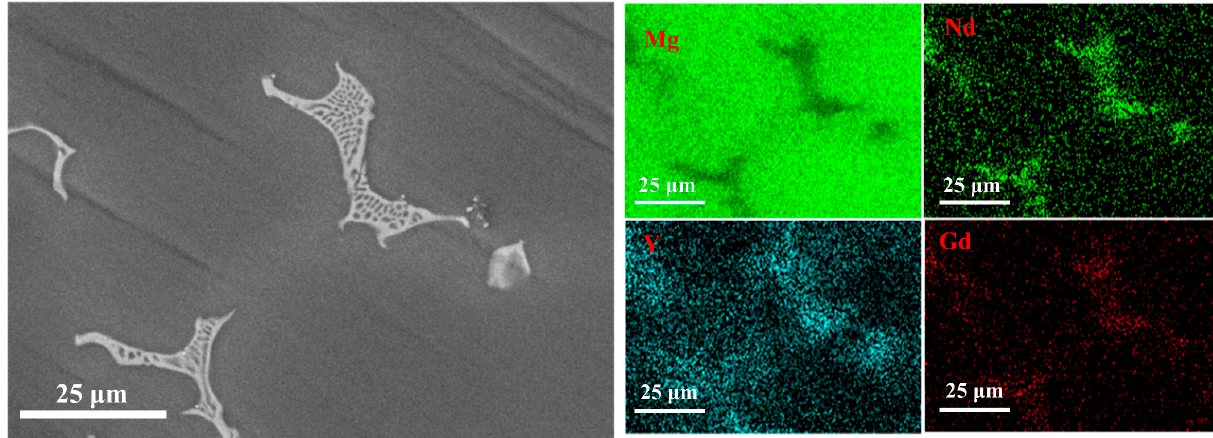
Figure 3. The EDS mapping of the second phases in WE43.